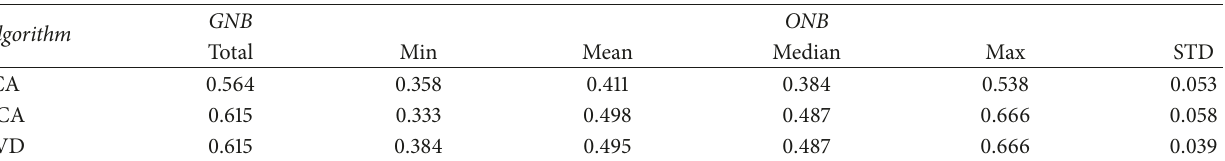
Table 2: Statistics of 51 runs of the optimized and Gaussian Naive-Bayes classifier with 10-fold cross-validation for ICA, PCA, and SVD data reduction algorithms.